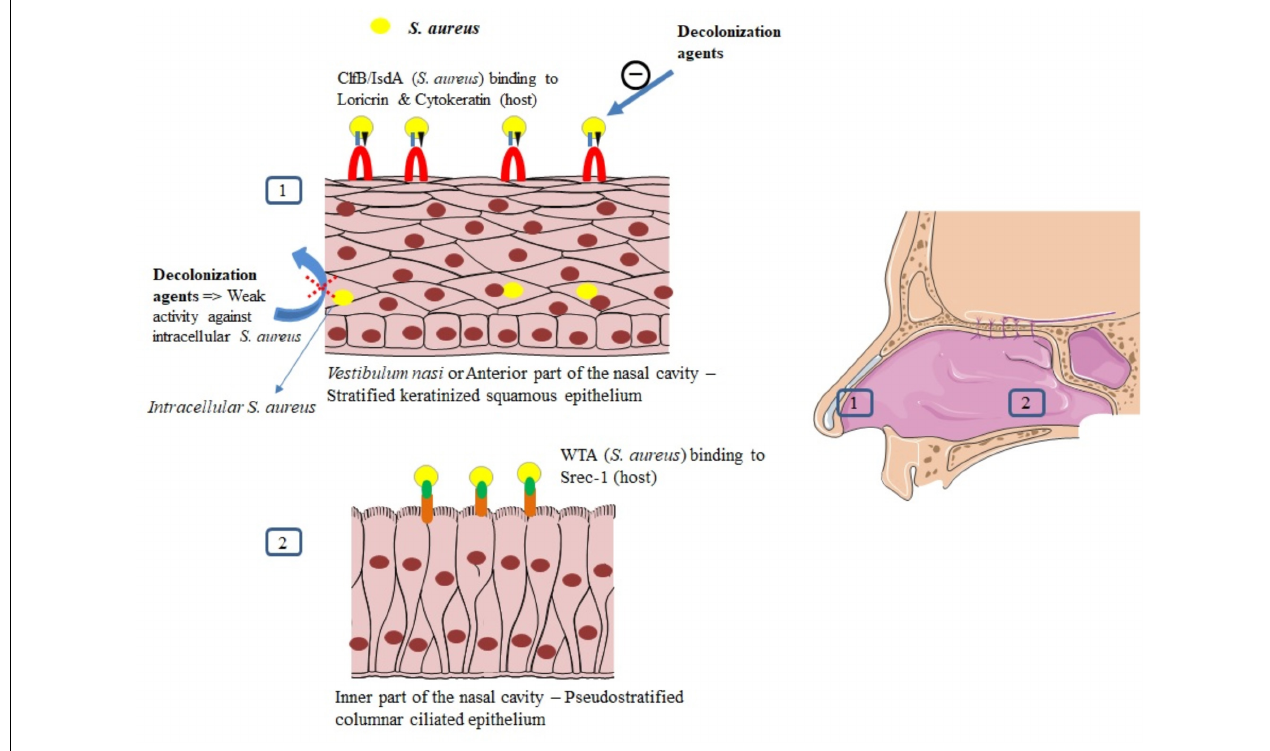
FIGURE 3 | Mechanisms of S. aureus nasal